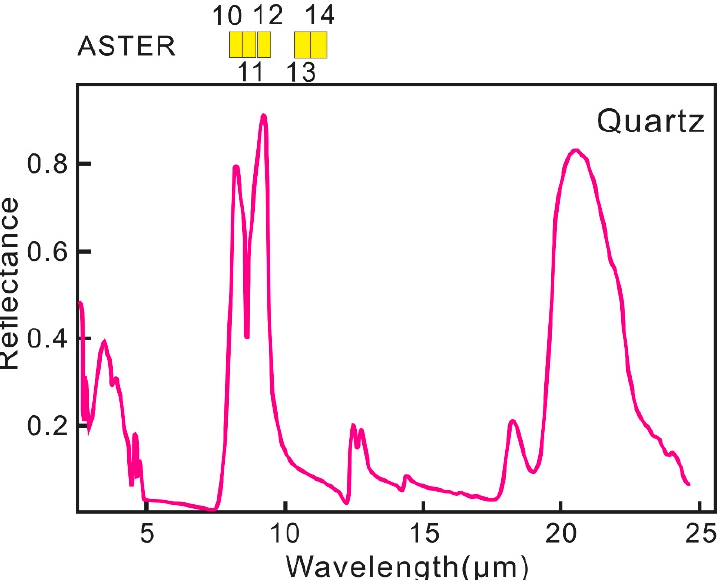
Figure 2. Spectral curves of quartz from thermal infrared spectra in ASTER data (the spectral curves from the USGS spectral library version 7). from the USGS spectral library version 7).